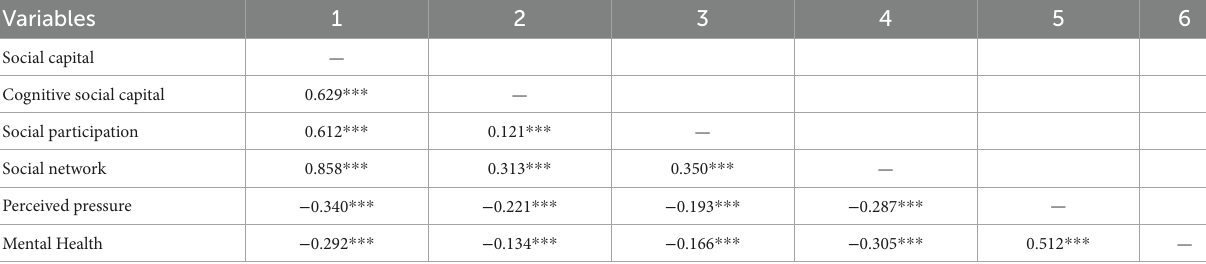
TABLE 3 Correlations analysis of social capital, perceived stress, and mental health ( n = 546). Variables